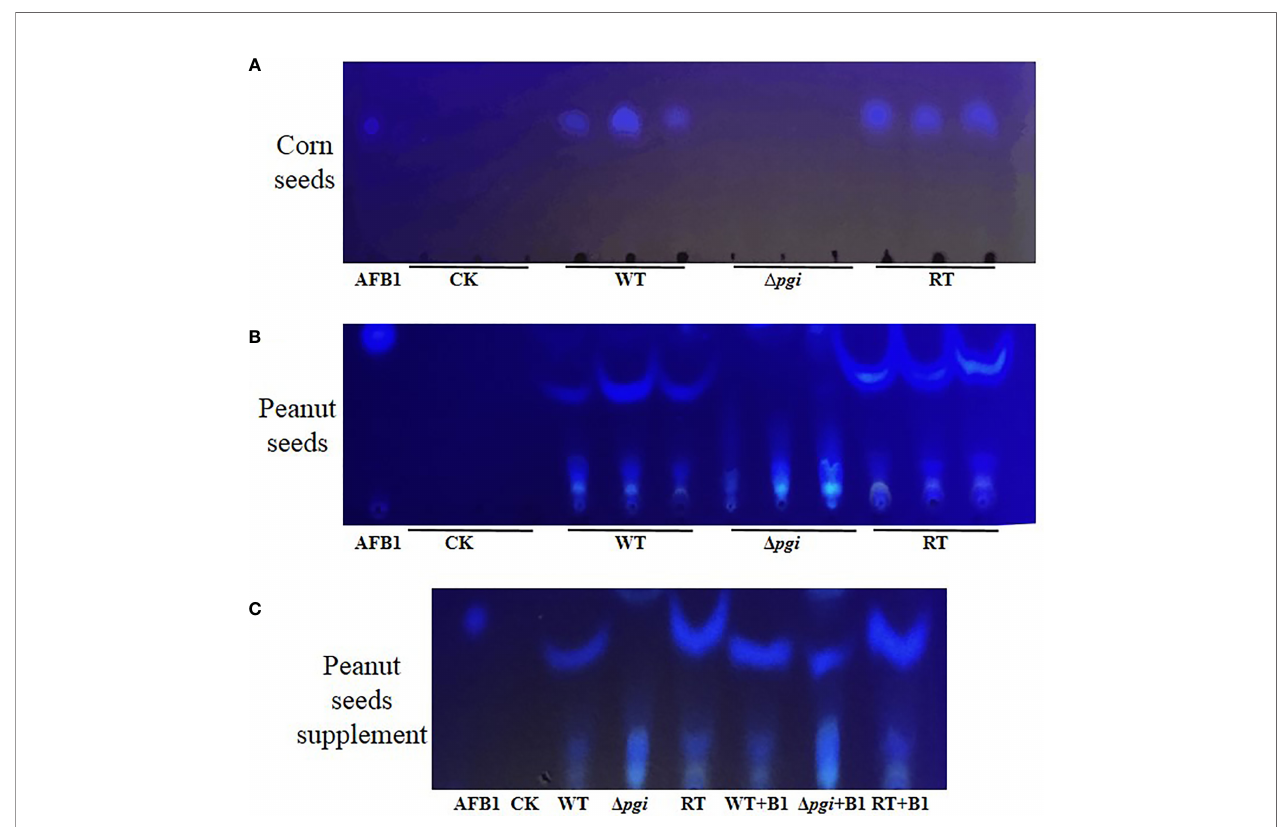
FIGURE 9 | TLC analysis of AFB1 accumulated in the seeds infected by A. fl avus strains. A fl atoxin was extracted from spore suspension washed from peanut and corn surface with equal amount of chloroform. Chloroform was used as control (CK). (A) TLC measurements of AFB1 extracted from corn seeds. (B) TLC measurements of AFB1 extracted from peanut seeds. (C) To verify the interference of peanut oil on TLC, AFB1 standard was added into each sample for